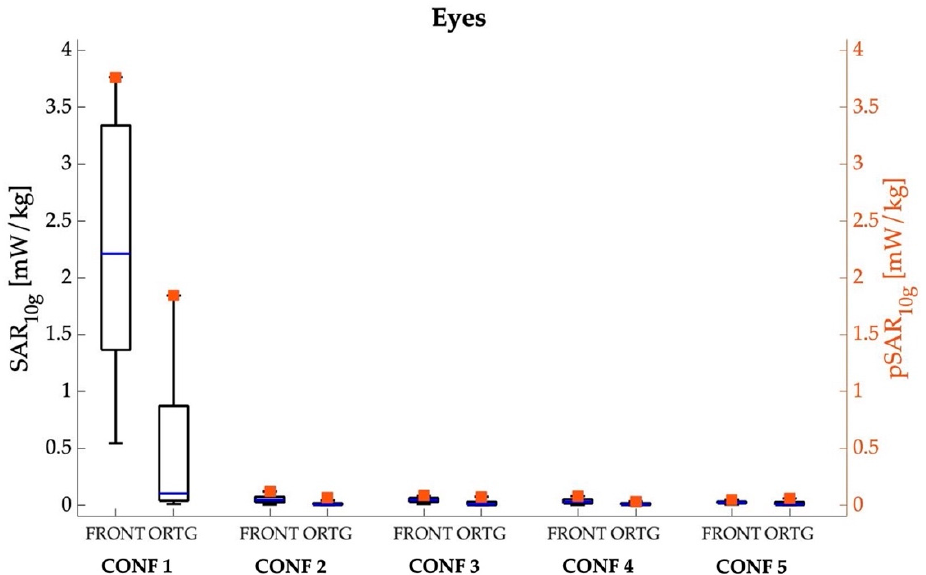
Figure 7. SAR 10g (left y -axis, box plot) and pSAR 10g (right y -axis, square symbols) in the eye tissues for the five different examined configurations, considering the frontal and orthogonal orientations of the Ella model. The center line in the boxes is the median; the bottom and top edges are the 25th and 75th percentiles. The lower whisker extends to the minimum value, while the upper whisker extends to 1.5 times the height of the box.